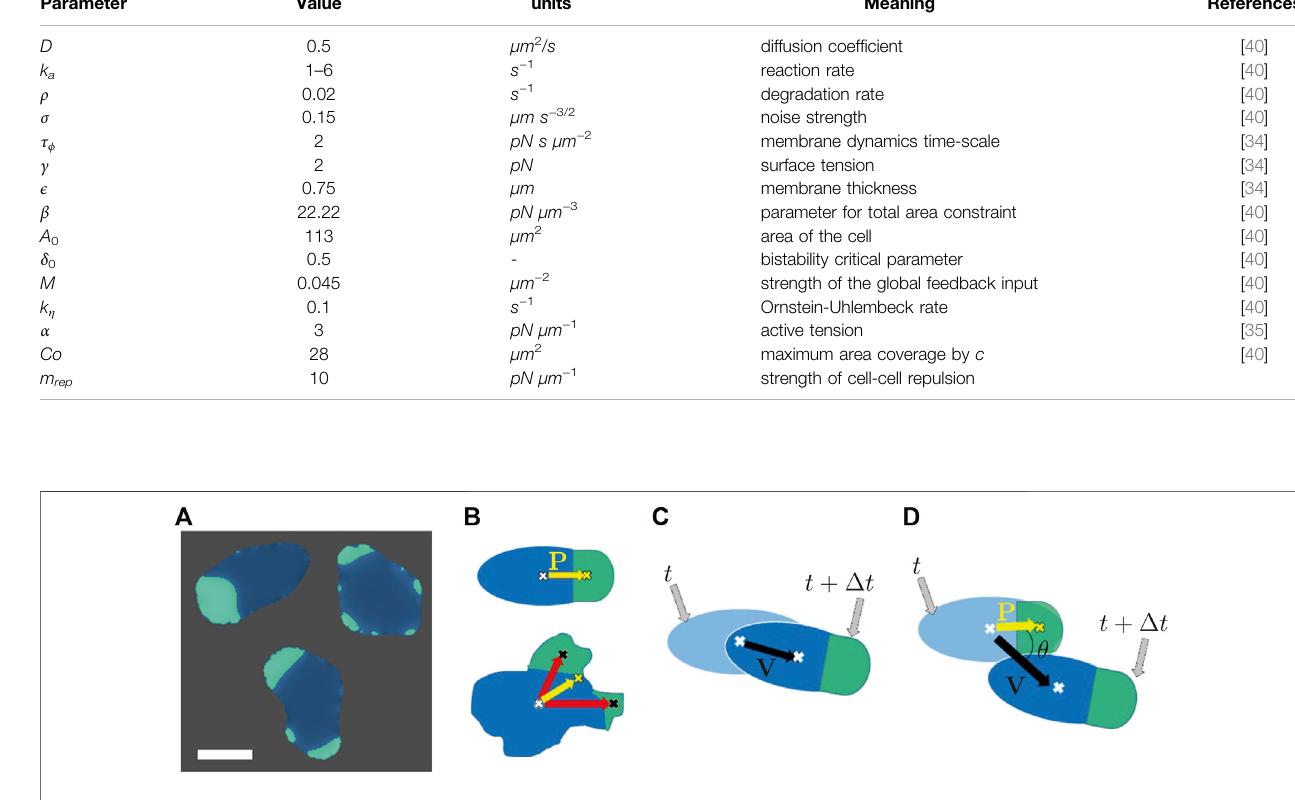
FIGURE 1 | (A) Snapshots of the different cell phenotypes as observed in numerical simulations. Green patches indicate the presence of the biochemical component c . Scale bar: 10 μ m . (B) Illustration of the calculation of the cell polarity vector P in the presence of one patch (top) or several patches (bottom). In the latter case, we consider the weighted average of the centroids of individual patches. The weights are determined by the respective patch size. (C) Illustration of the spatial displacement of a cell in the time interval from t to t + Δ t . (D) Graphical representation of the angle θ between cell polarity P and velocity vector V